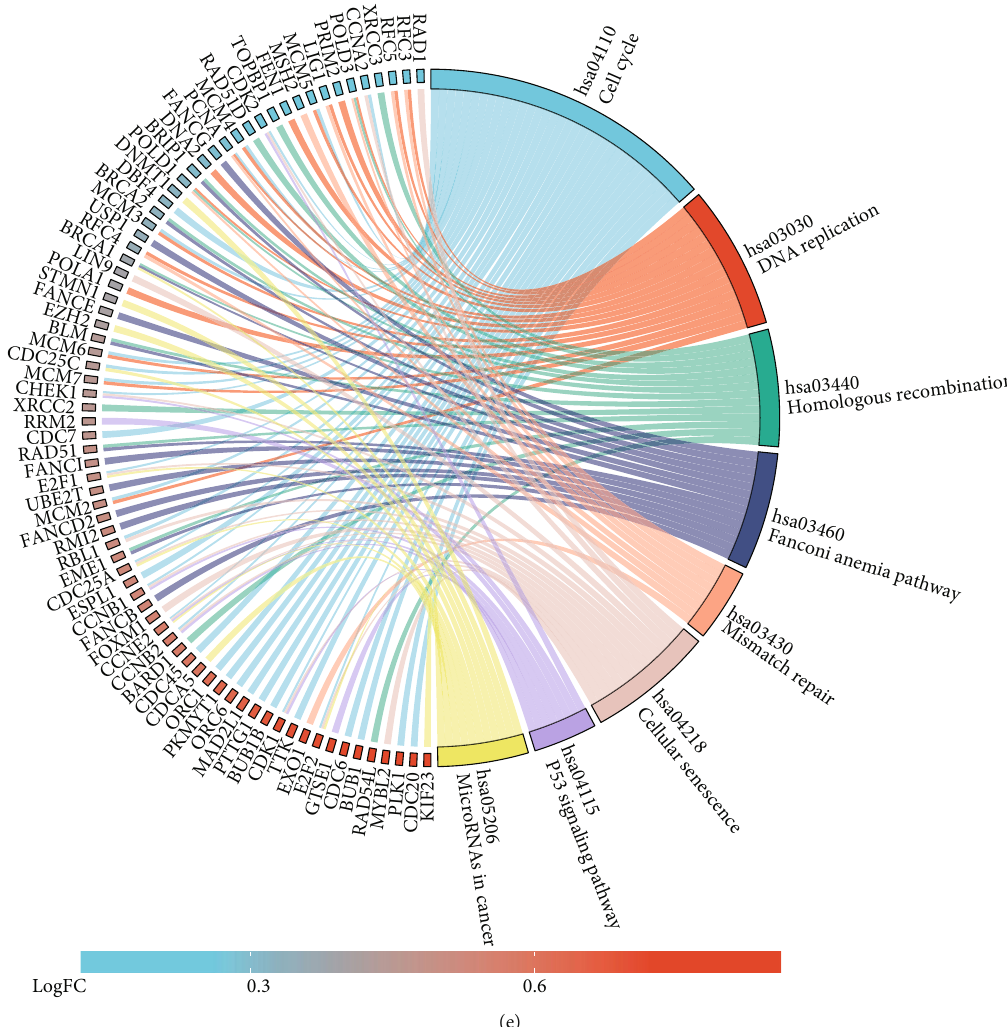
Figure 5: GO and KEGG enrichment analyses for genes co-expressed with PRC1. (a) Co-expression heat map of the TOP 50 genes related with PRC1. We conducted GO and KEGG analyses of the top 300 PRC1-related genes. Enrichment terms in BP (b), CC (c), MF (d), and KEGG pathway (e) were